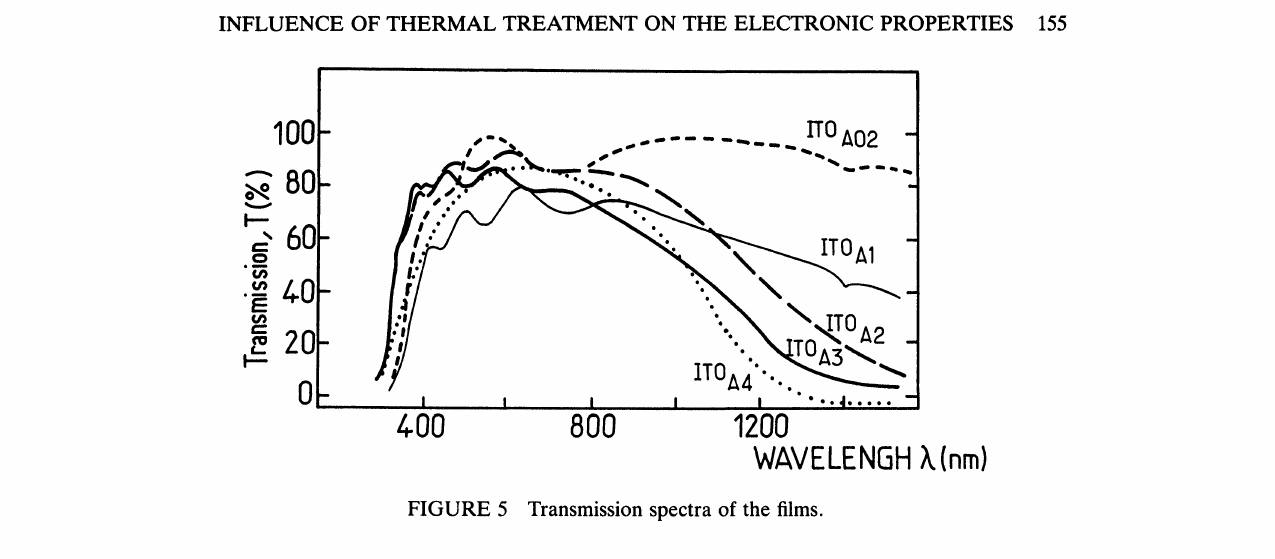
FIGURE 5 Transmission spectra of the films.